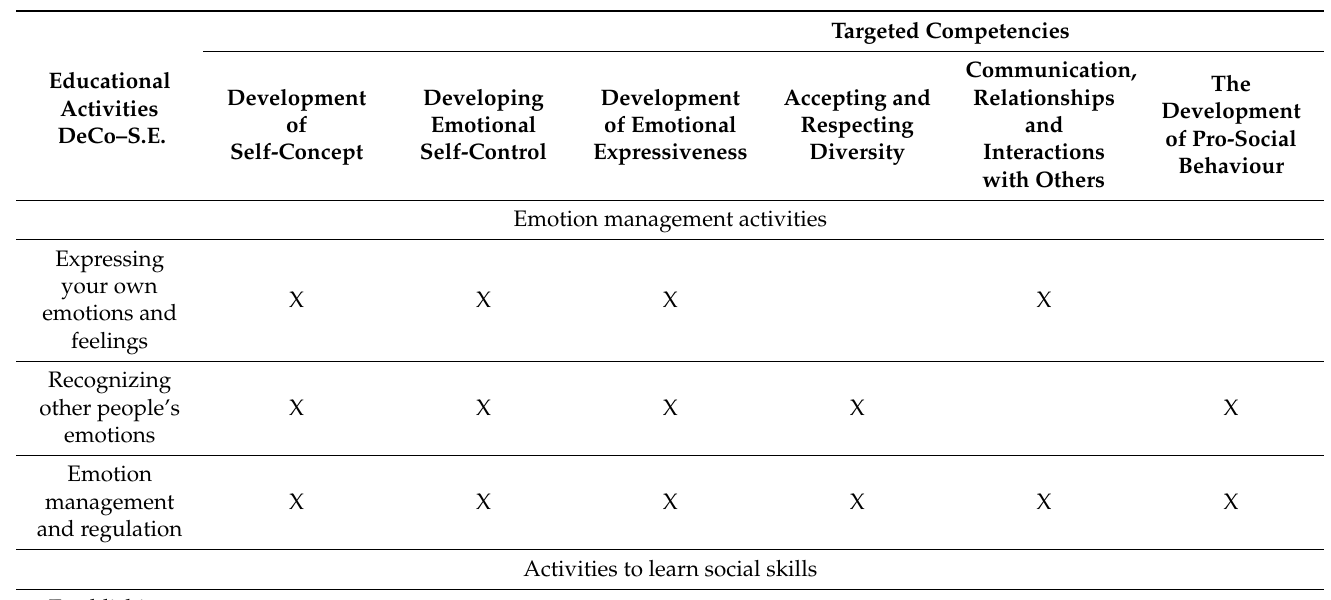
Table 3. Content of the DeCo-S.E.